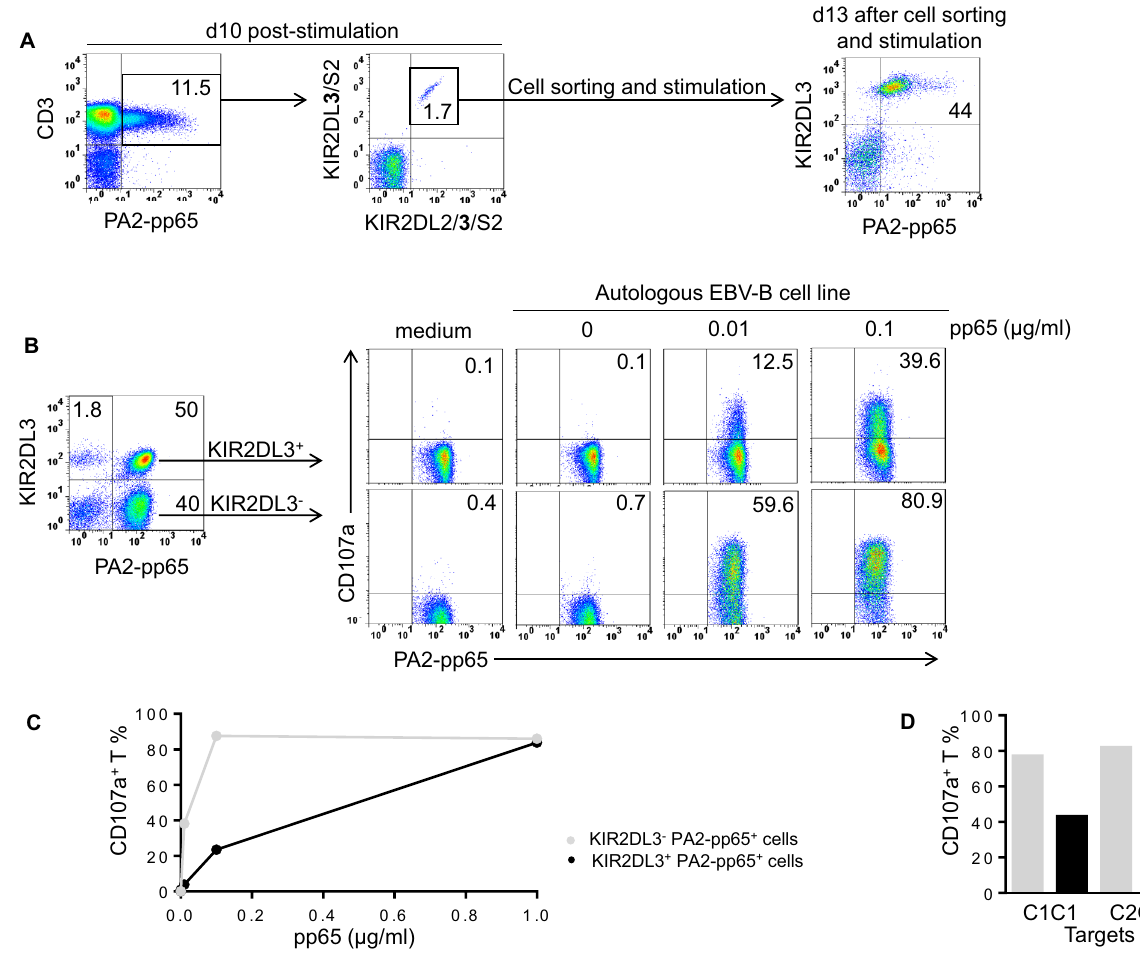
Figure 4. KIR2DL3 inhibits the degranulation of HLA-A2-pp65 specific T lymphocytes. (A) PBMC from HLA-A2 + CMV + individuals were stimulated using pp65 loaded autologous PBMC following the ratio E: T of 1:1. After 10 days of stimulation, HLA-A2-pp65 specific T lymphocytes were targeted using specific pentamer (PA2-pp65) in combination with KIR2DL2/3/S2 specific mAb (GL183) and KIR2DS2/KIR2DL3 specific mAb (1F12). KIR2DL3 + PA2-pp65 + lymphocytes were cell sorted and in vitro amplified by stimulation